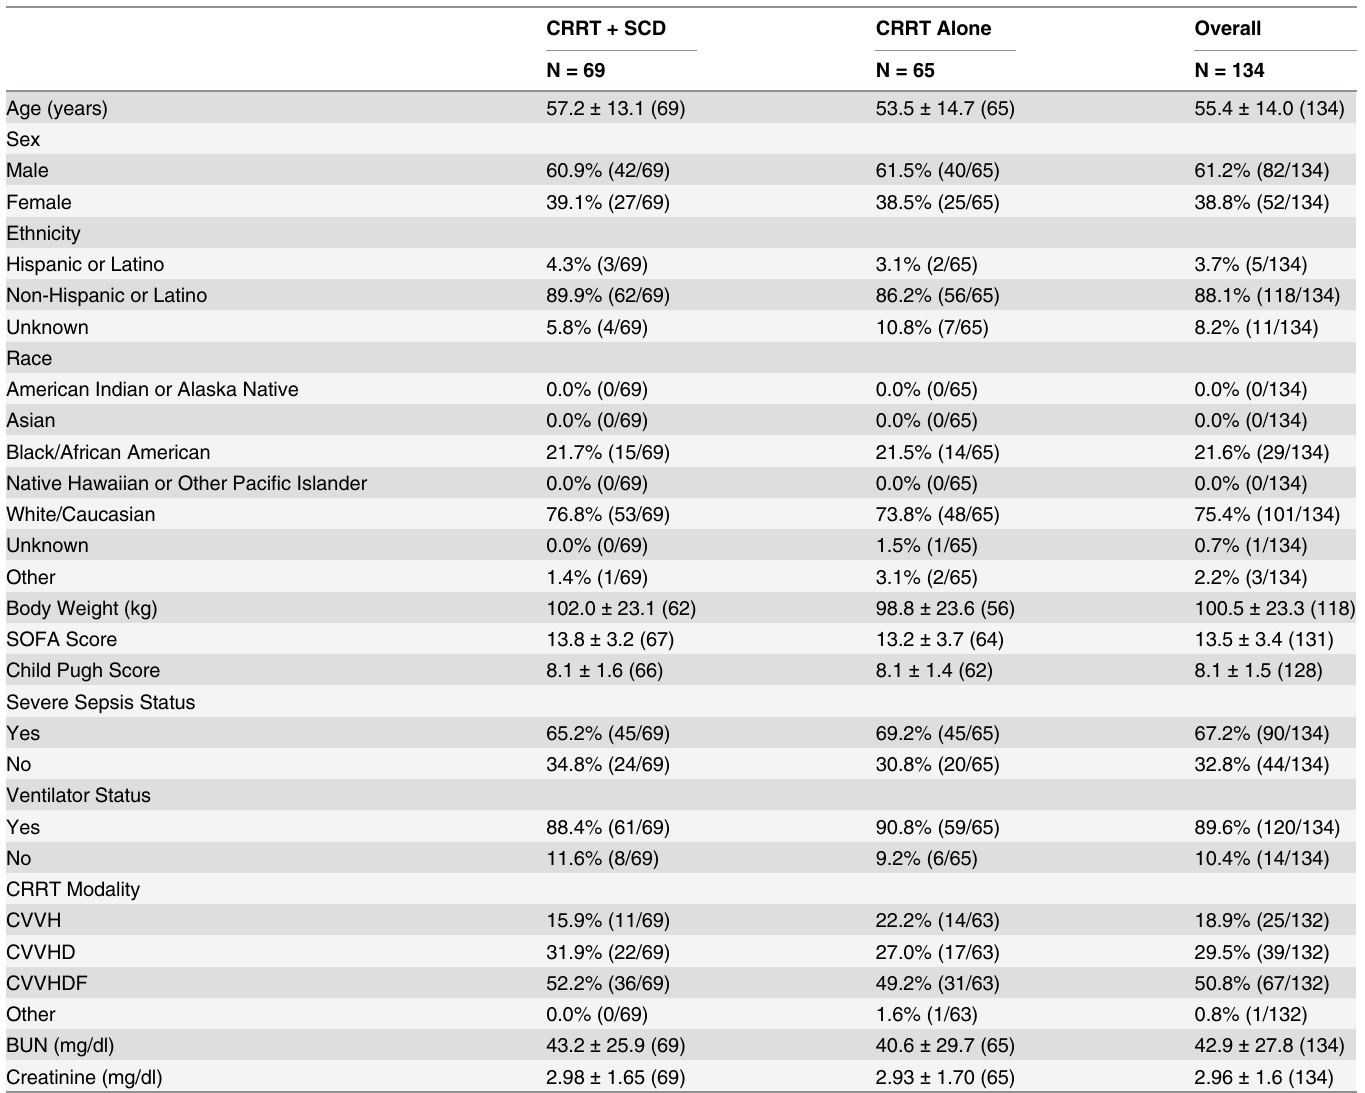
Table 3. Demographics of All Study